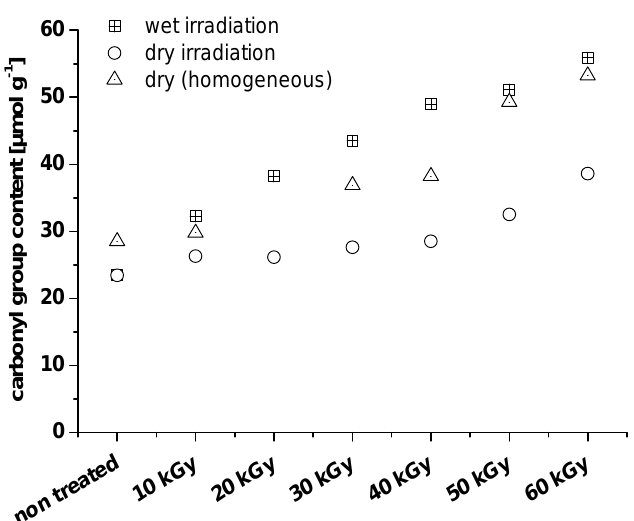
Figure 3. Comparison of nanocrystalline celluloses that have been irradiated as wet or dry material. The dry material has additionally been analyzed after homogeneous labeling.